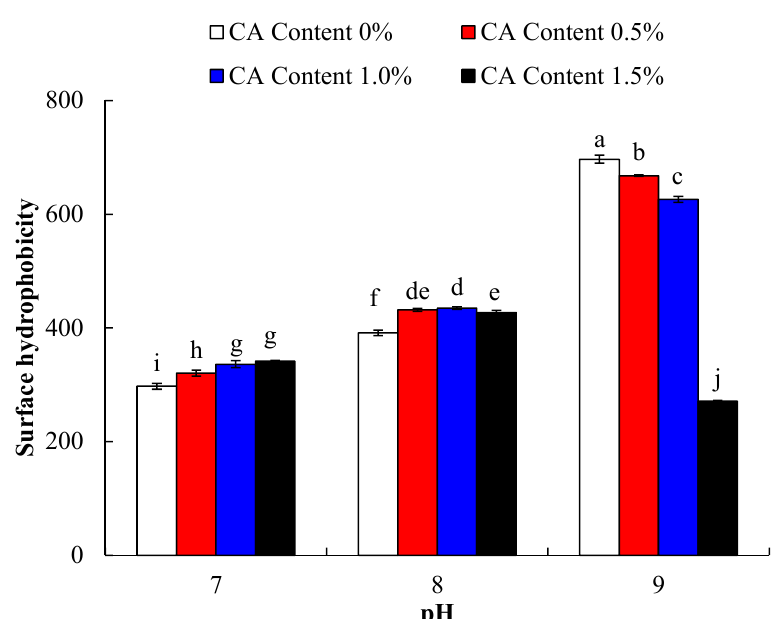
Figure 1. Surface hydrophobicity of WPI incubated with CA (0, 0.5, 1.0 and 1.5%) at pH 7.0, pH 8.0, or pH 9.0, at 50 °C for 6 h. Error bars represent the standard deviation of the mean of triplicate experiments. Values with different letters are significantly different ( p < 0.05).